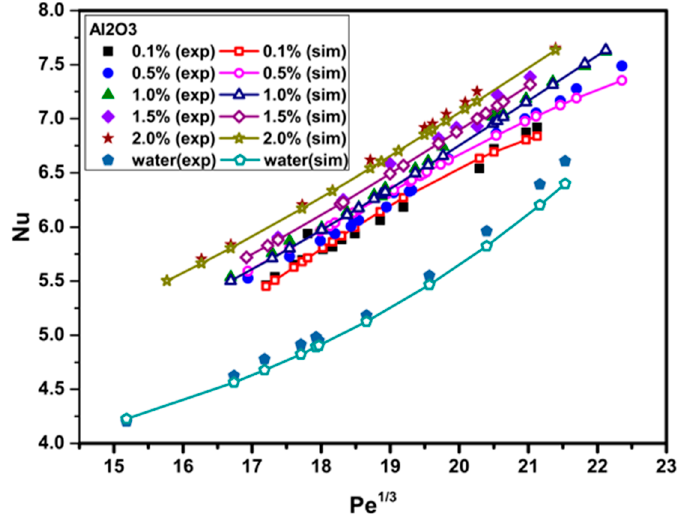
Figure 8. Comparison between numerically-predicted and experimentally-measured Nusselt numbers at various particle volume concentrations and Pe values for Al 2 O 3 /water nanofluids.